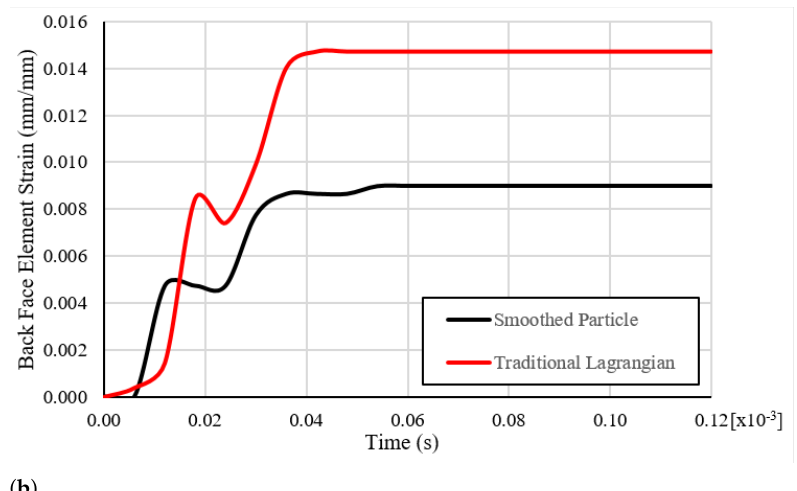
Figure 15. Element Strain versus Time: ( a ) Projectile Impact Face, ( b ) Projectile Back Face.